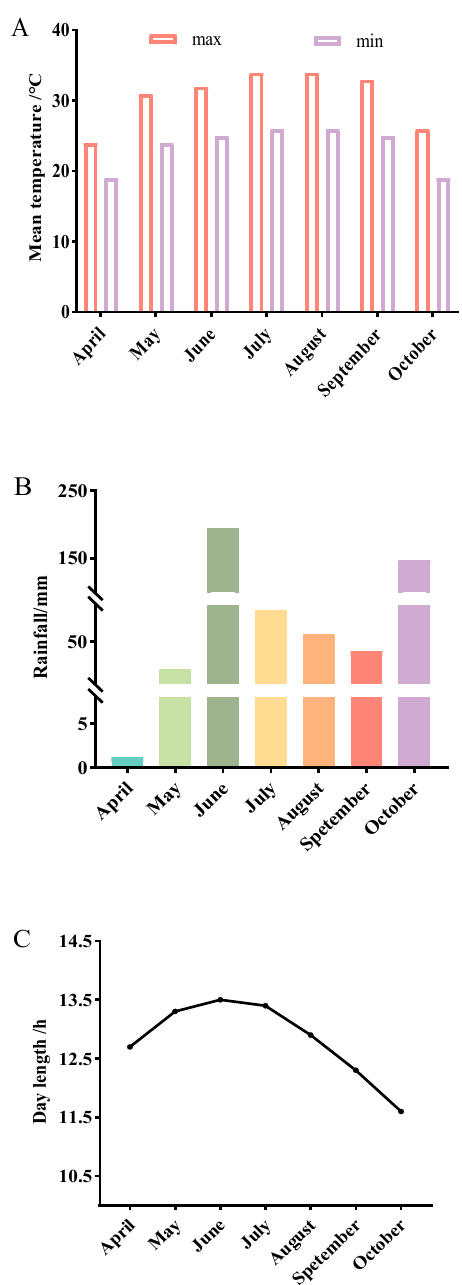
Figure 1. Wuming climate conditions during the cowpea growing seasons. ( A ) Mean temperature in Wuming across three sowing seasons. ( B ) Precipitation in Wuming across three sowing seasons. ( C ) Day length in Wuming across three sowing seasons. The temperature and rainfall data were obtained from https://www.tianqi24.com/wuming/history202104.html (accessed on 29 September 2022), whereas the day length data were obtained from https://richurimo.bmcx.com/wumingxian__richurimo/?ivk_sa=1023345p (accessed on 29 September 2022) .